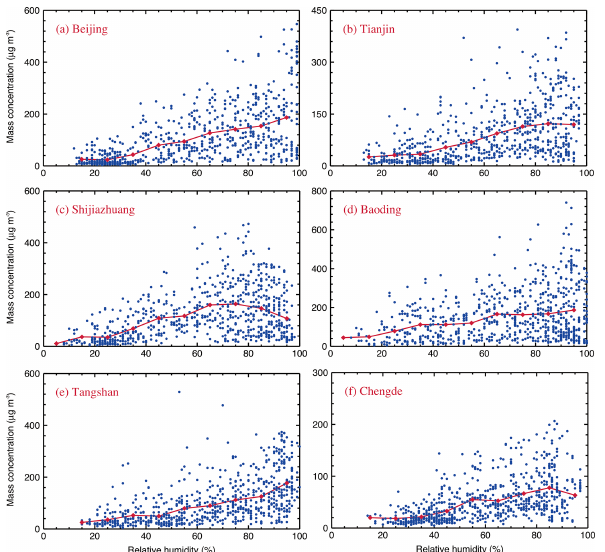
Figure 2. Scatter plots of near-surface [PM 2 . 5 ] and RH at six typi- cal polluted cities in NCP during the 2015 wintertime. The red di- amond shows the bin average of near-surface [PM 2 . 5 ], and the red line denotes the variation in the bin average of near-surface [PM 2 . 5 ] with RH.